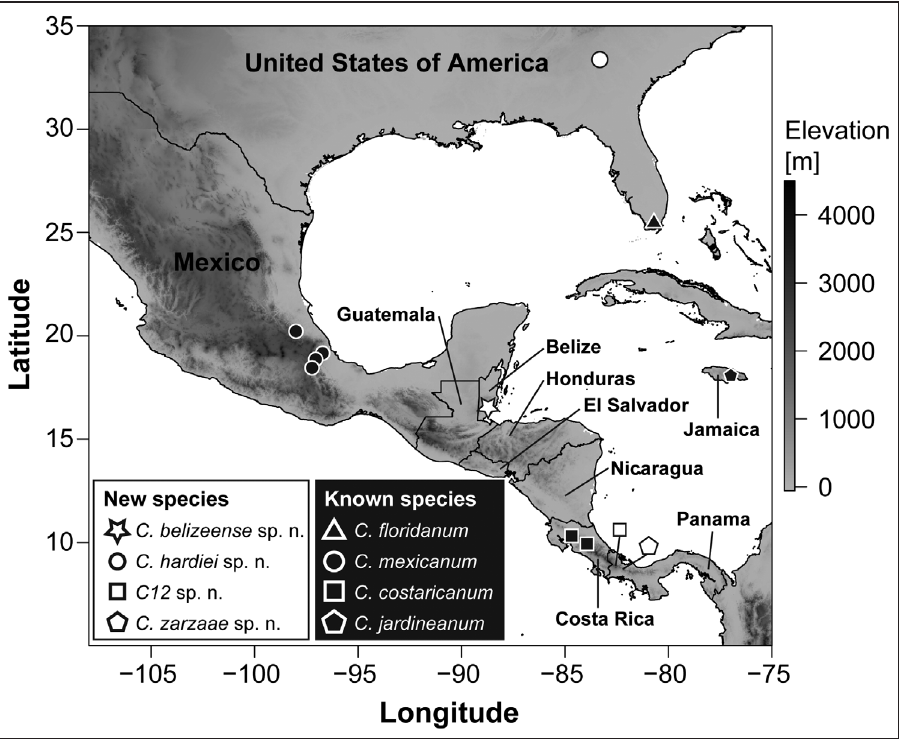
Figure 1. Map indicating geographic position of the new Carychium species and type localities of the North American and Central American allied species C. mexicanum , C. costaricanum , and C. floridanum . Carychium jardineanum is included in context for Jamaica. The grayscale indicates the local mean eleva- tion. This map was downloaded from WORLDCLIM (Hijmans et al. 2005) and political borders were retrieved from Esri Data and Maps